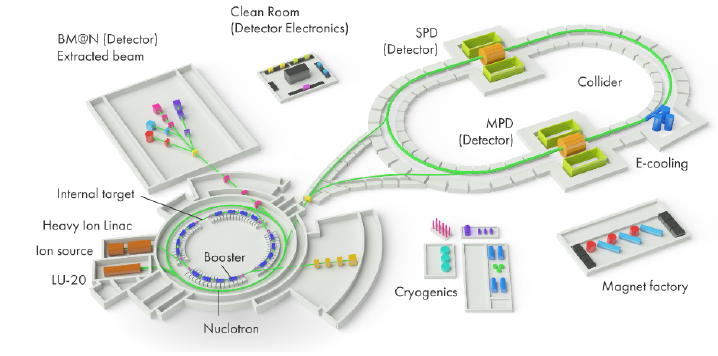
Figure 1. The NICA accelerator complex [1]